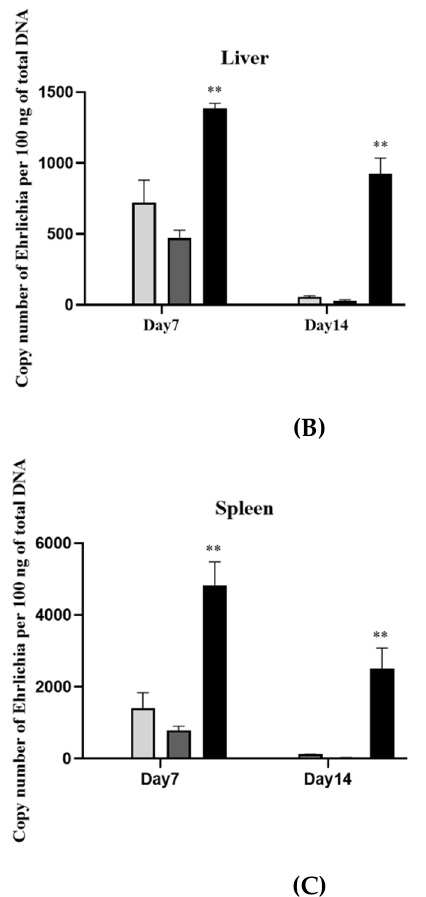
Figure 3. Immunization with rGP19 provided protection against Ehrlichia canis infection in mice. The protection against E. canis infection in the immunized mice with rGP19 was determined by the ehrlichial load in the blood ( A ), liver ( B ), and spleen ( C ) samples measured by quantitative PCR (qPCR) and showed lower ehrlichial loads on days 7 and 14 post-challenge (** p < 0.01) compared with mice immunized with adjuvant.